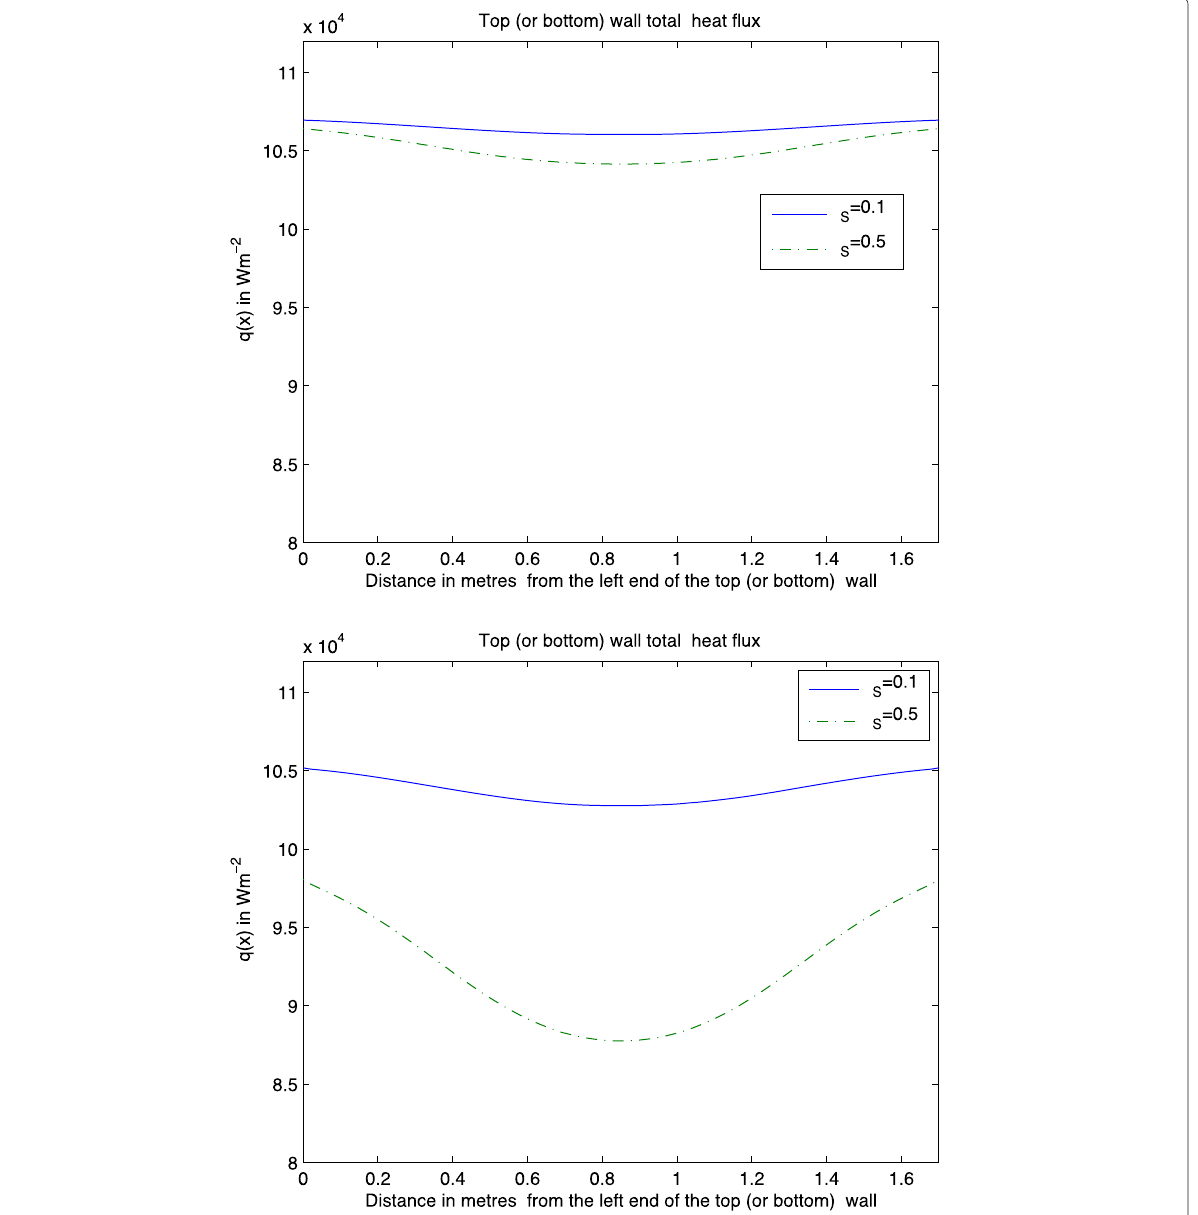
Fig. 8 Distributions of q ( x ) on the top(orbottom) wall. The topplot : (cid:7) W = 0.9; The bottomplot : (cid:7) W =